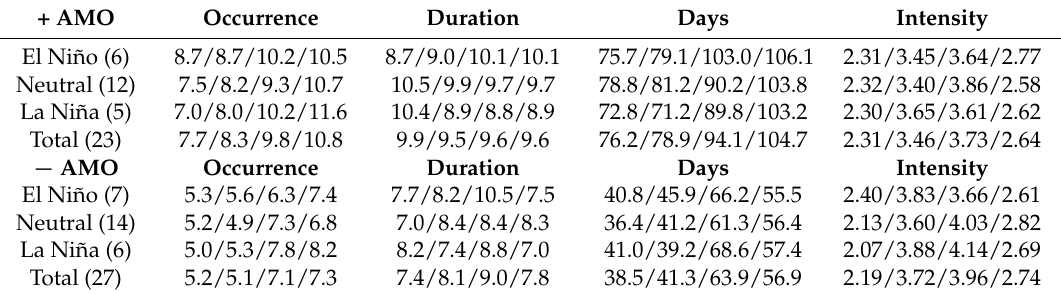
Table A4. As in Table A2, except as a function of ENSO and AMO.